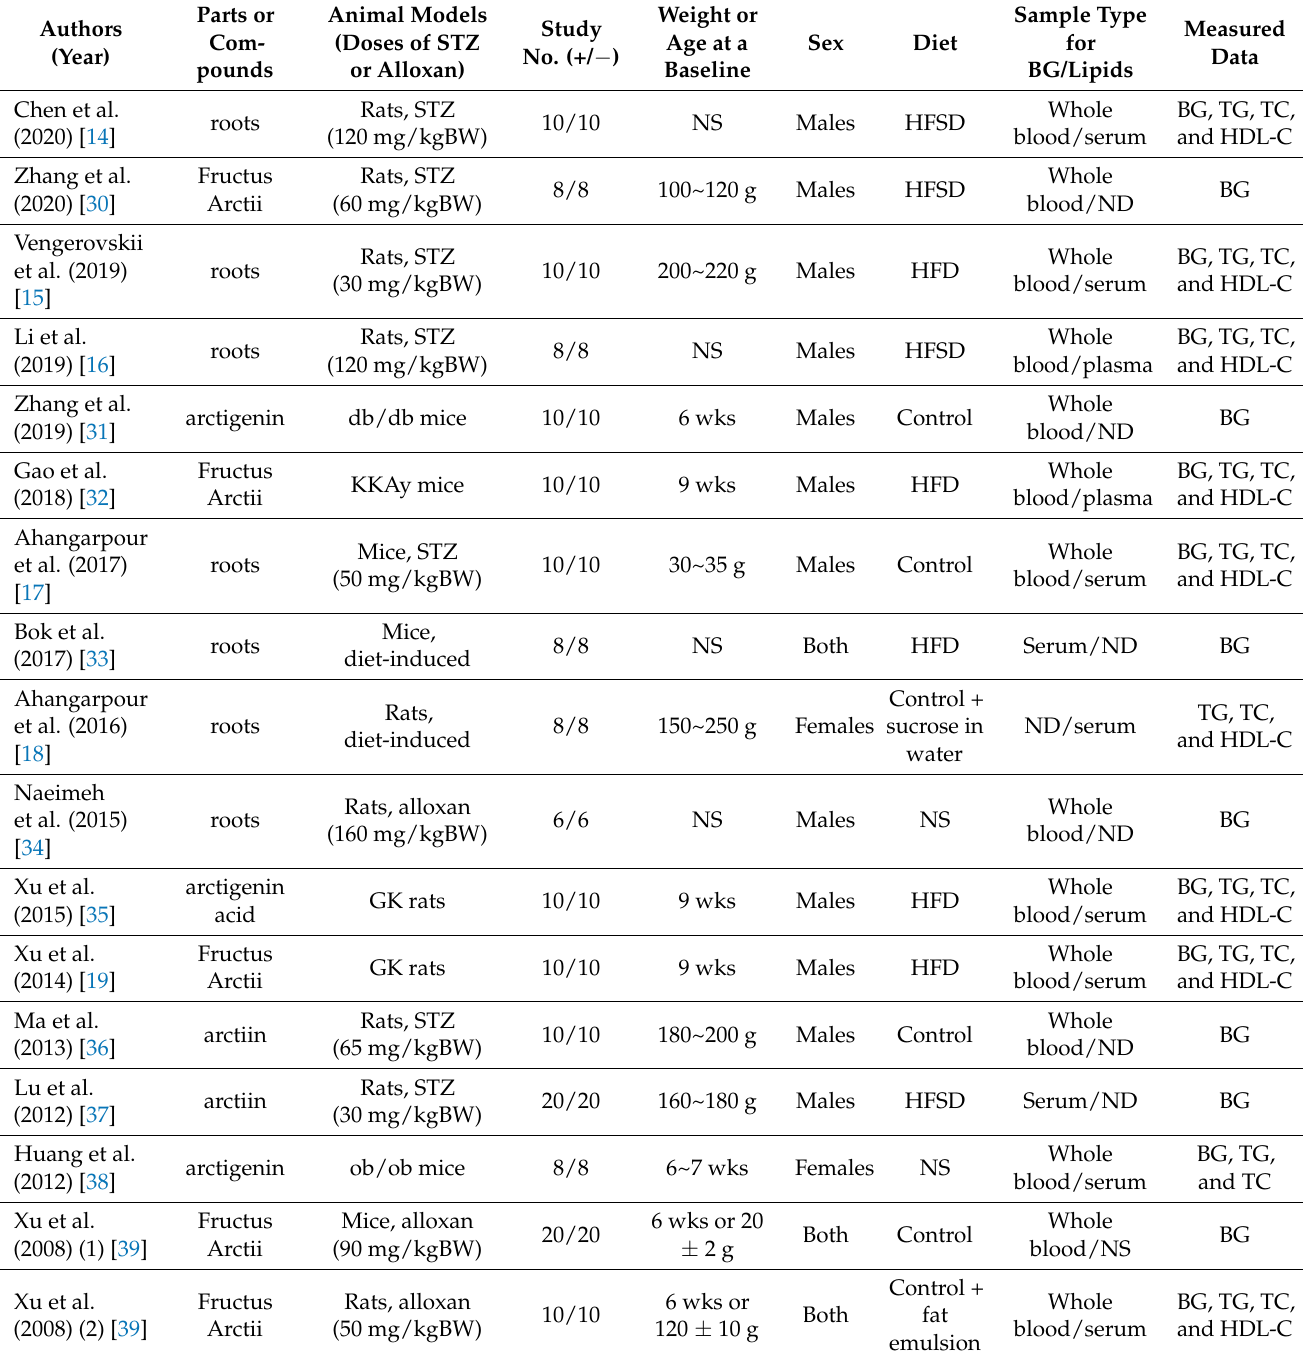
Table 1. Characteristics of included studies for the